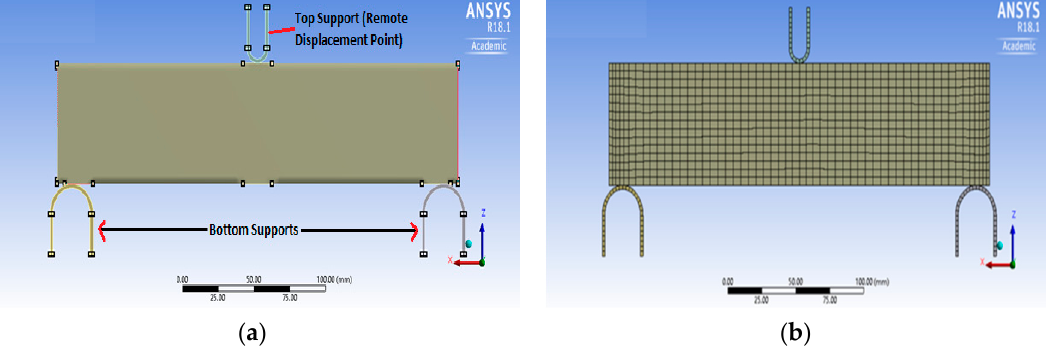
Figure 2. Three-point bending test schematic setup and FEA details: ( a ) the three-point bending test schematic setup, modeled in FEA, and ( b ) schematic of the meshed CFRP box beam in FEA. Numerical modelling of the composite beams was performed using the commercial finite element analysis software ANSYS (FEA software, Canonsburg, PA, USA) [29]. Solid meshing the CFRP beam. This element is defined by eight nodes with three degrees of